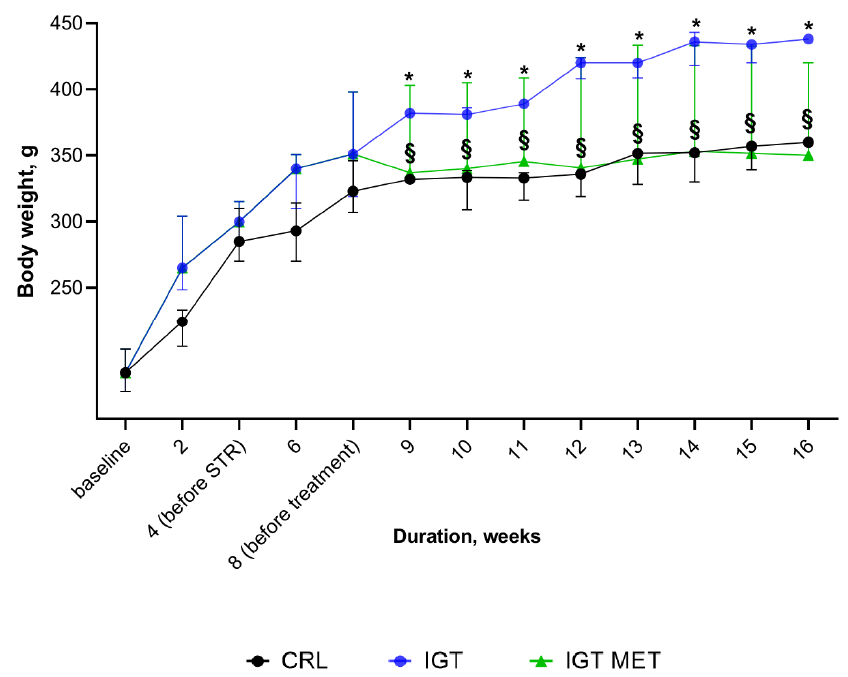
Figure 1. Dynamic of body weight in study groups. Notes: C- CRL (control group), IGT—impaired glucose tolerance group, IGT MET—impaired glucose tolerance + metformin group. Results are presented as median (25%; 75%). * p < 0.05, in comparison with CRL group, § p < 0.05, in comparison with IGT group.